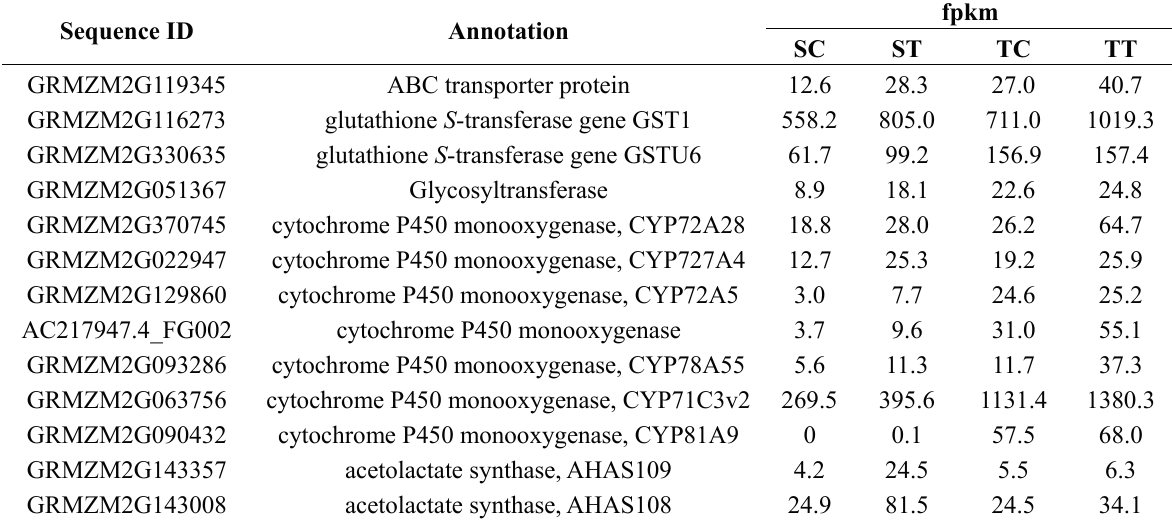
Table 1. Differentially expressed candidate genes between nicosulfuron-susceptible (S) and TT: nicosulfuron-treated tolerant